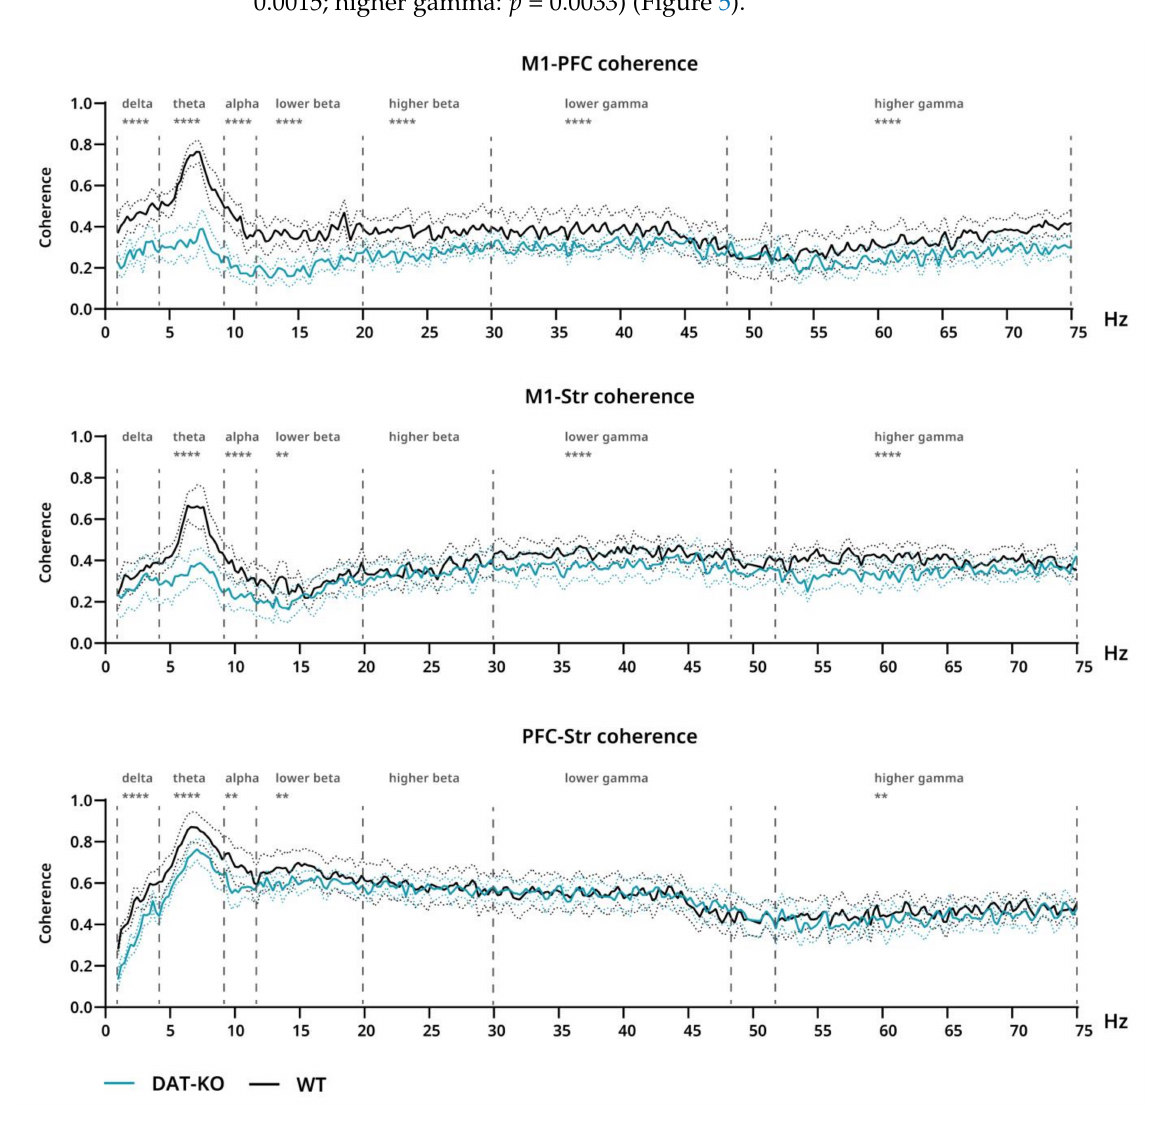
Figure 5. Coherence of brain activity of DAT-KO (teal) and WT (black) rats. Interareal coherence is presented for pairs of brain areas: motor cortex (M1), prefrontal cortex (PFC) and striatum (Str). Degree of coherence is expressed in fractions of one. Data are presented as mean (solid line) ± SEM (dotted line). Dashed lines represent electroencephalographic rhythms: delta (0.9–3 Hz), theta (4–8 Hz), alpha (9–11 Hz), lower beta (12–19 Hz), higher beta (20–29 Hz), lower gamma (30–48), higher gamma (52–74 Hz). ** p < 0.01; **** p < 0.0001; two-way